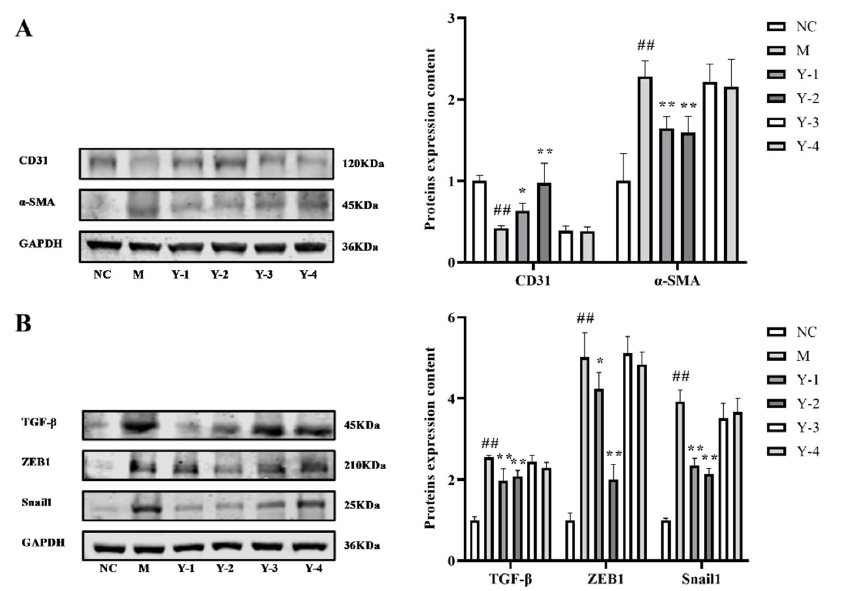
Figure 3. Effects of phenolic compounds from Mori Cortex on NRK-52e cells’ EMT and fibrosis stimulated by sodium oleate. The expression of CD31 and α -SMA protein in NRK-52e cells were quantified by Western blot and normalized ( n = 3) ( A ). The expression of TGF- β ZEB1 and Snail1 protein in NRK-52e cells were quantified by Western blot and normalized ( n = 3) ( B ); ## p < 0.01 compared with NC group, * p < 0.05, ** p < 0.01 compared with M group.